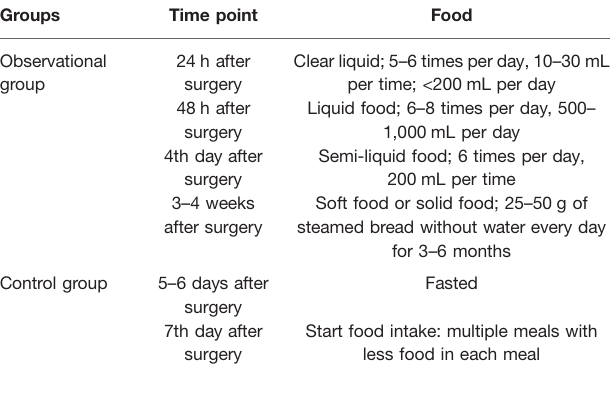
TABLE 1 | Instructions of new food to patients in different groups.